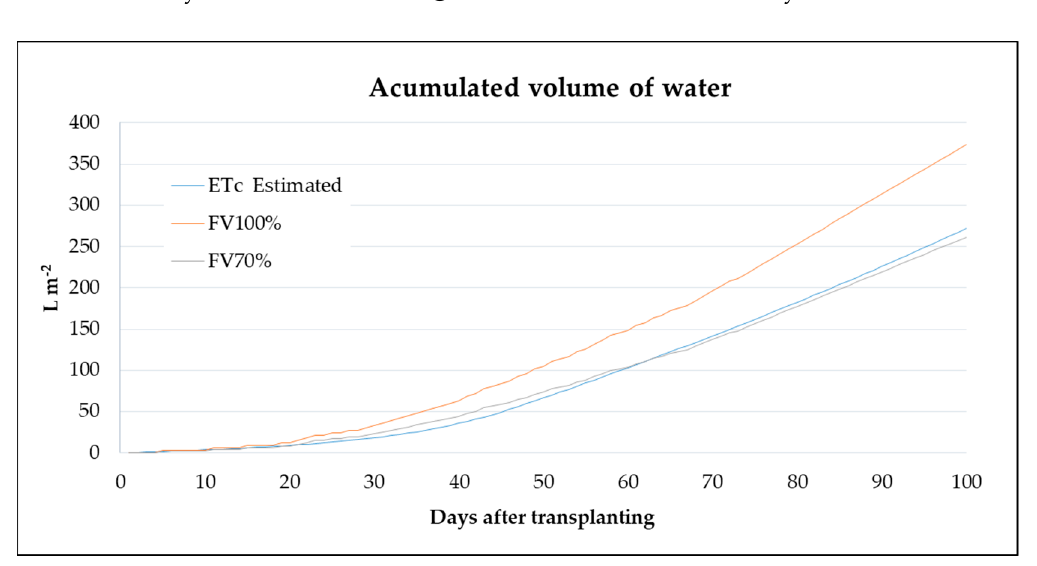
Figure 3. Accumulated volume of water applied in the FV100%% and FV70% treatments during the cultivation cycle and estimated ETc by software PrHo v 2.0 © 2020 for the cultivation cycle.